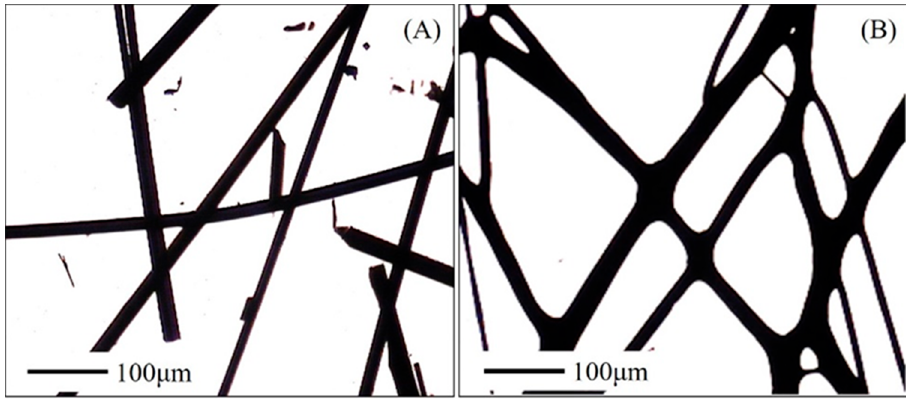
Figure 1. Microscopic images of the primary fiber ( A ) and thermostabilized fibers ( B ) heated in air from room temperature to 250 °C at the heating rate of 1 °C/min.